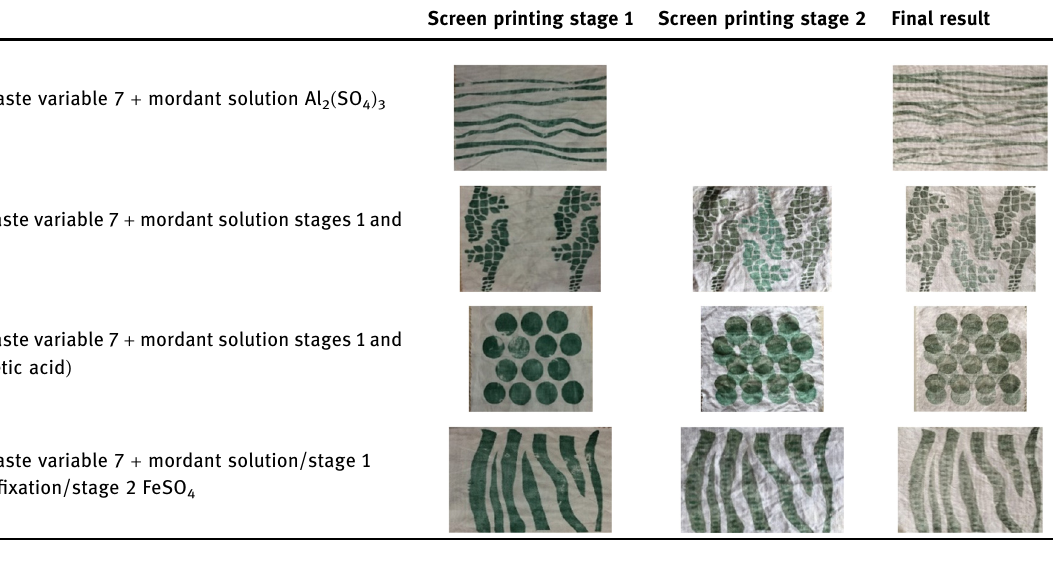
Table 8: Test results of color fastness to domestic laundering Types of